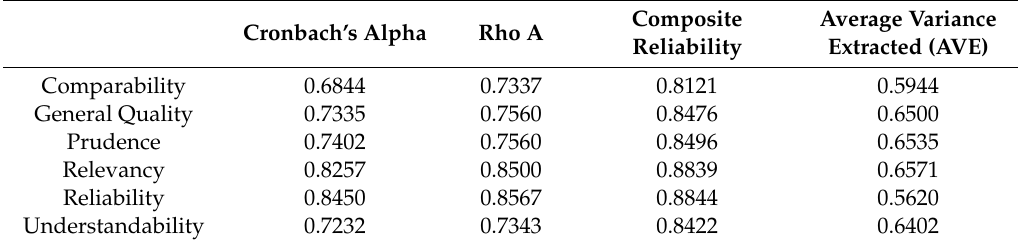
Table 3. Construct Reliability and